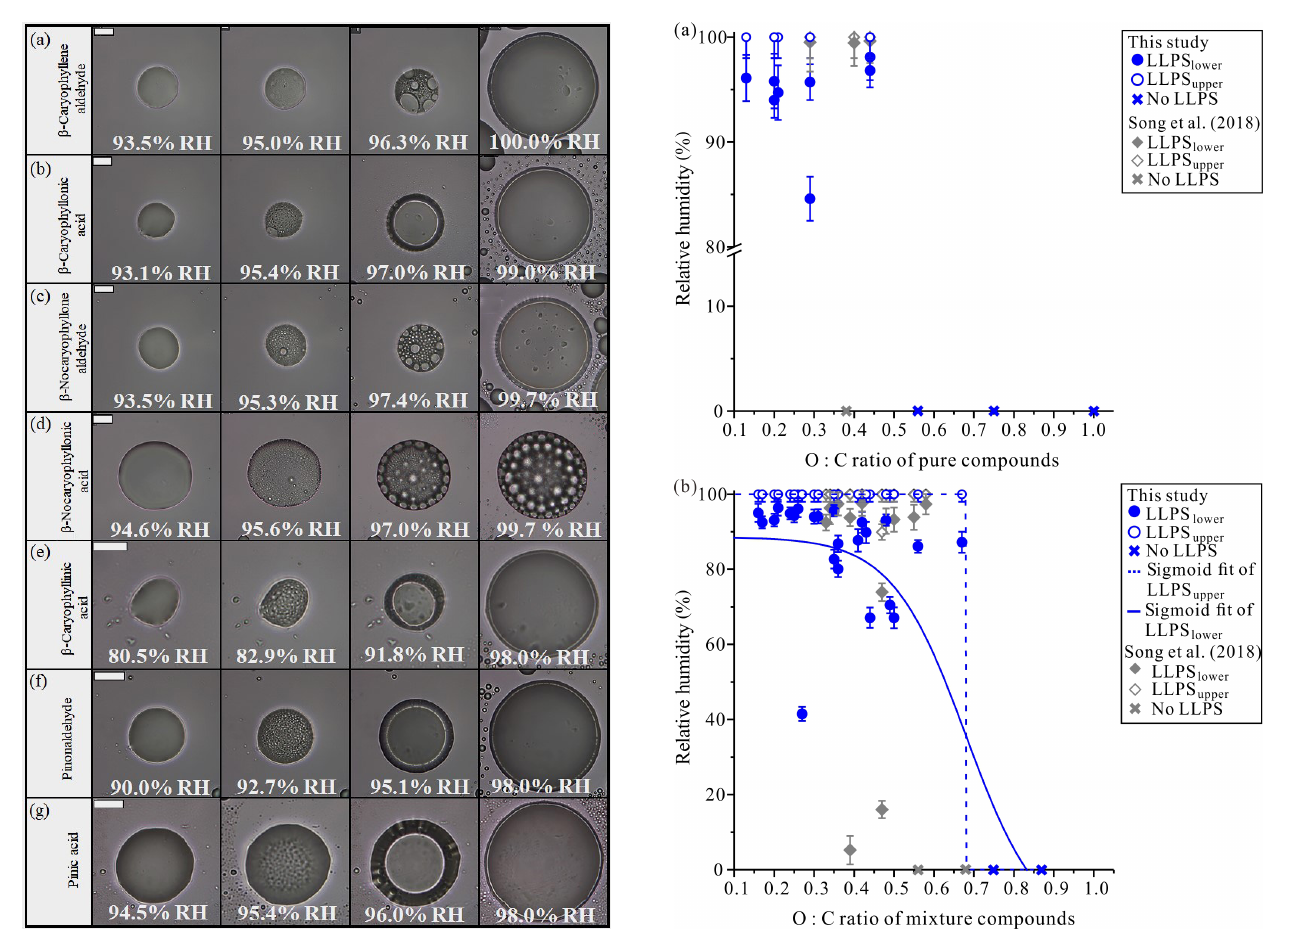
Figure 2. Optical images of particles for increasing RH: (a) β -caryophyllene aldehyde, (b) β -caryophyllonic acid, (c) β - nocaryophyllone aldehyde, (d) β -nocaryophyllonic acid, (e) β - nocaryophyllinic acid, (f) pinonaldehyde, and (g) pinic acid. The particles are the same ones in Fig. 1. The last columns indicate the upper RH boundary for LLPS (LLPS upper ) with increasing RH. The scale bar is 20µm.